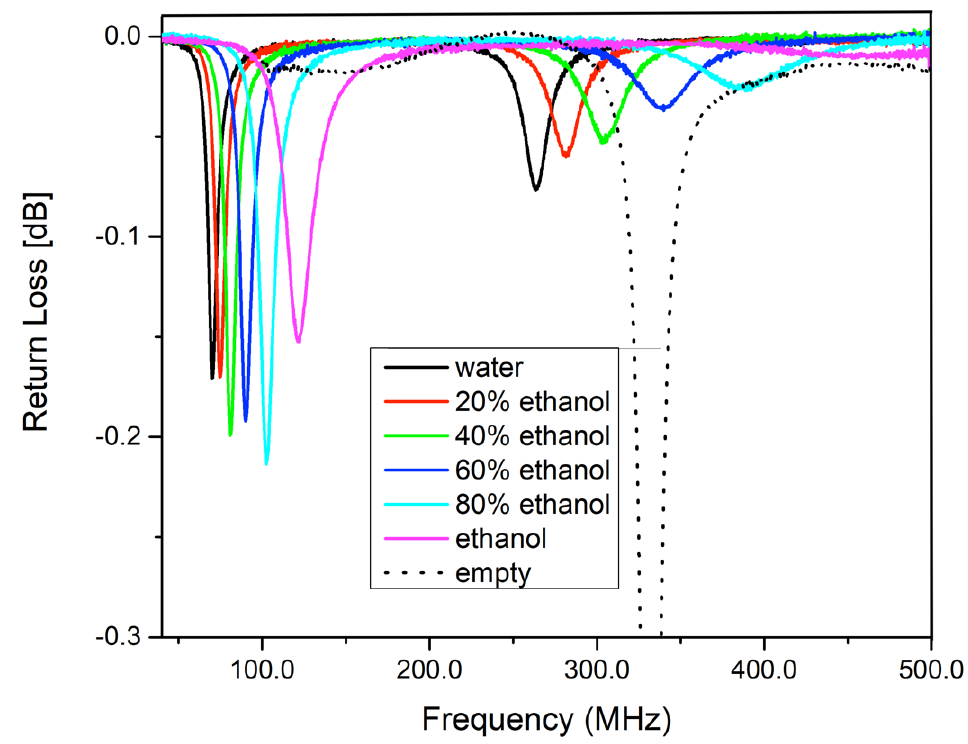
Figure 4. Return loss of the sampling cell filled with water, ethanol, and selected mixtures. This last curve had to be truncated because is considerably more intense than all the other curves. The lowest frequency peak of the empty cell is centered at 332 MHz, but it moves to 70 MHz and 122 MHz when the cell is filled with water and ethanol,